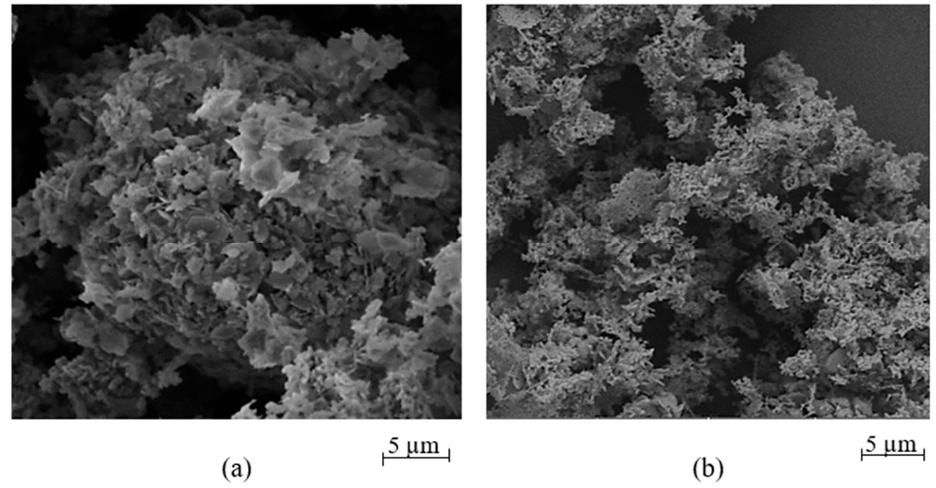
Figure 4. SEM images of hydrocalumite precursors: ( a ) HC000 and ( b ) HC700.